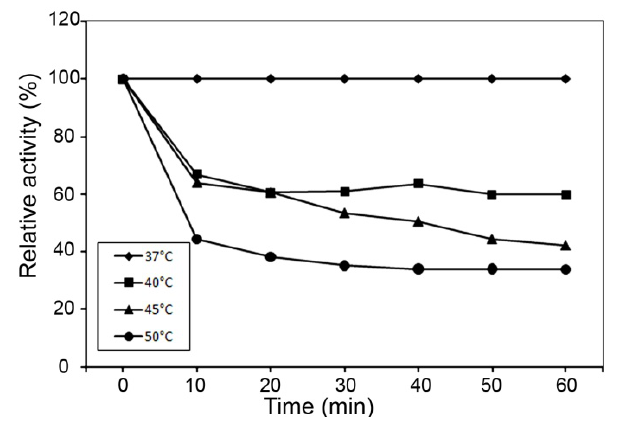
Figure 5. Thermostability of MnSOD 47 activity.